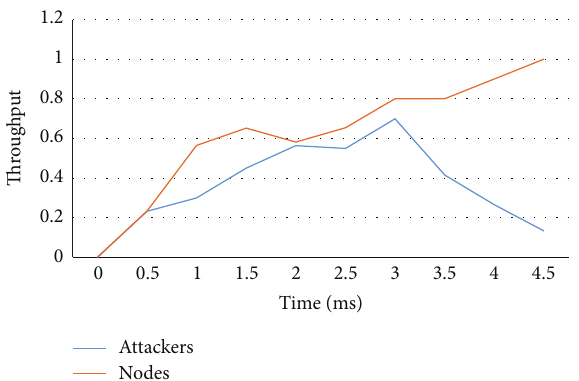
Figure 3: Throughput for 4 legitimate nodes versus 1 jammer.